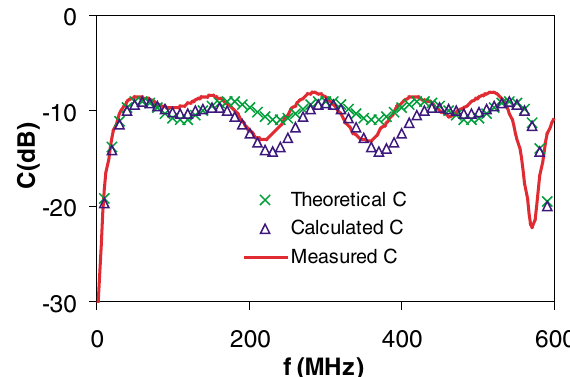
FIG. 11. (Color) Coupling factor of the final coupler. The ripple of the measured coupling factor (red line) is reasonably close to both the theoretical (green crosses) and calculated (blue tri- angles) behavior in the relevant frequency range (20 to 530 MHz, as explained in the